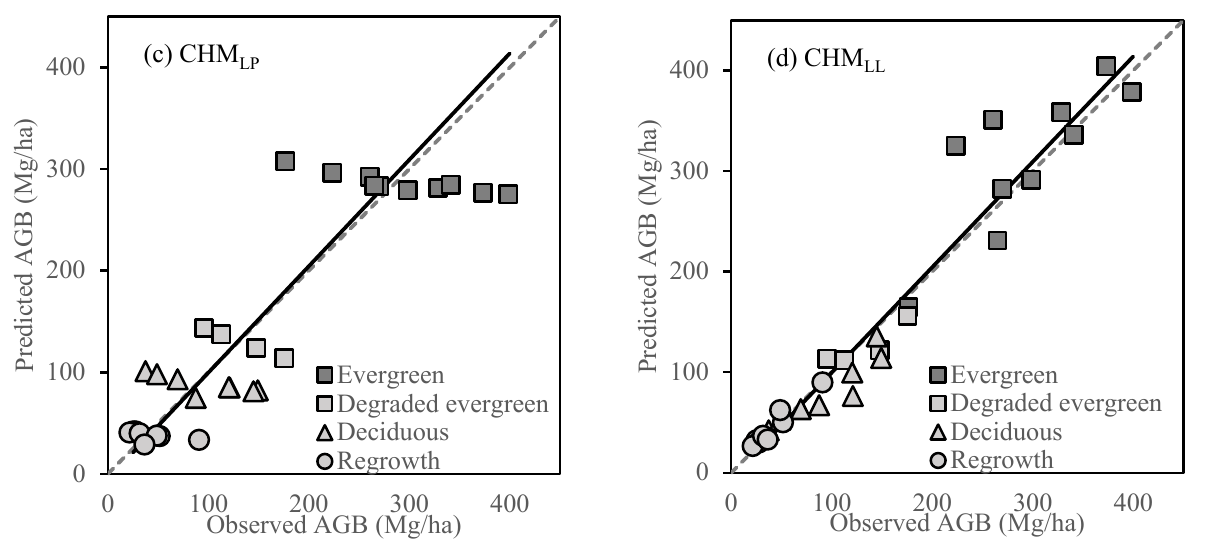
Figure 3. Observed aboveground biomass (AGB) versus predicted AGB from the best model of each of the canopy height models (CHMs). ( a ) CHM PP ; ( b ) CHM PL ; ( c ) CHM LL . A diagonal dotted line and a cross solid line indicate the 1:1 line and regression line between predicted AGB and observed AGB,